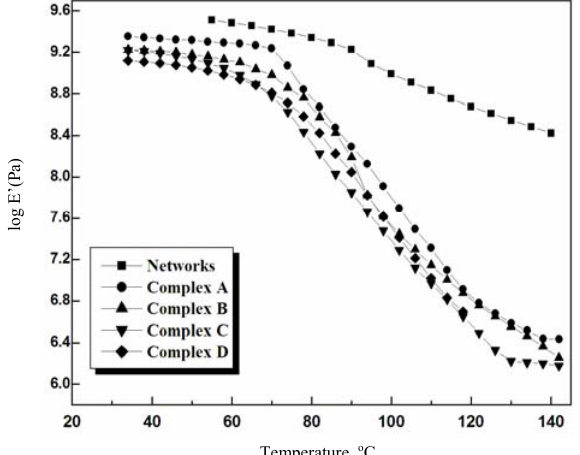
Figure 3. Temperature dependence of tensile storage modulus E' for P(MAA-co-MMA) network and various P(MAA-co-MMA) / PVP